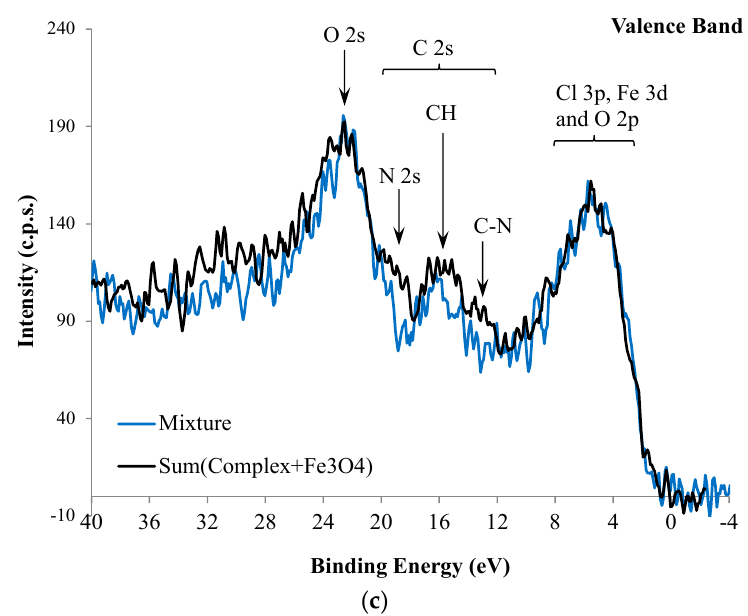
Figure 1. XPS regions ( a ) C 1s and ( b ) Fe 2p of (from top to bottom): Fe 3 O 4 , [FeCl 2 { κ 3 ‐ HC(pz) 3 }] ( 1 ) and their mixture ( 2 ). ( c ) Comparison of the mixture valence band with the sum of [FeCl 2 { κ 3 ‐ HC(pz) 3 }] and Fe 3 O 4 valence bands.